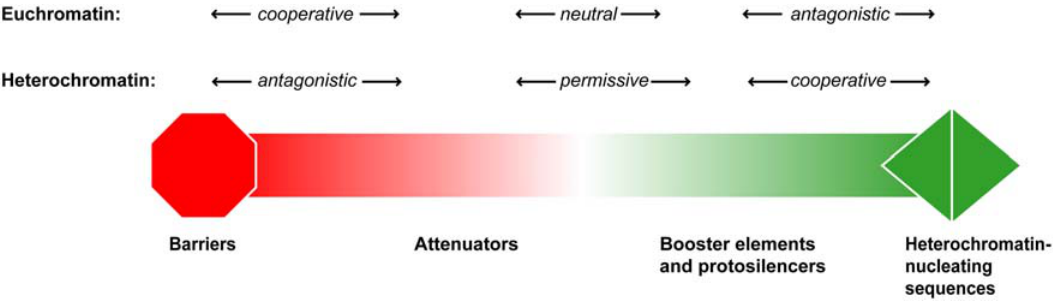
Figure 7. The continuum of DNA sequence, its effects on heterochromatin spreading, and the balance between opposing heterochromatic and euchromatic forces. The range of DNA sequences and the magnitude of their interaction with DNA is depicted along a gradient ranging from heterochromatin barriers (red) to heterochromatin nucleating sequences (green). The italic text above the figure describes the effect of a specific DNA sequence on both heterochromatin and euchromatin. Below the figure is a classification system that subdivides the continuum.